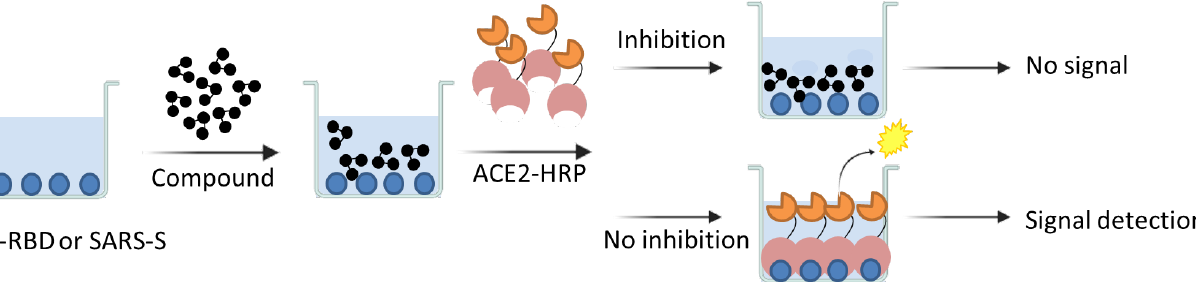
Figure 1. Scheme of a competitive ELISA. Recombinant RBD and SARS-CoV-2 protein trimer were used for sorption in the wells of the plate. After addition, incubation, and washing, recombinant ACE2 – HRP was added. The substrate for HRP was then added. For the wells that inhibited the RBD – ACE2 interaction, there was no signal or it was weak. For the wells where no inhibition occurred, a signal associated with enzymatic conversion of the substrate was observed.